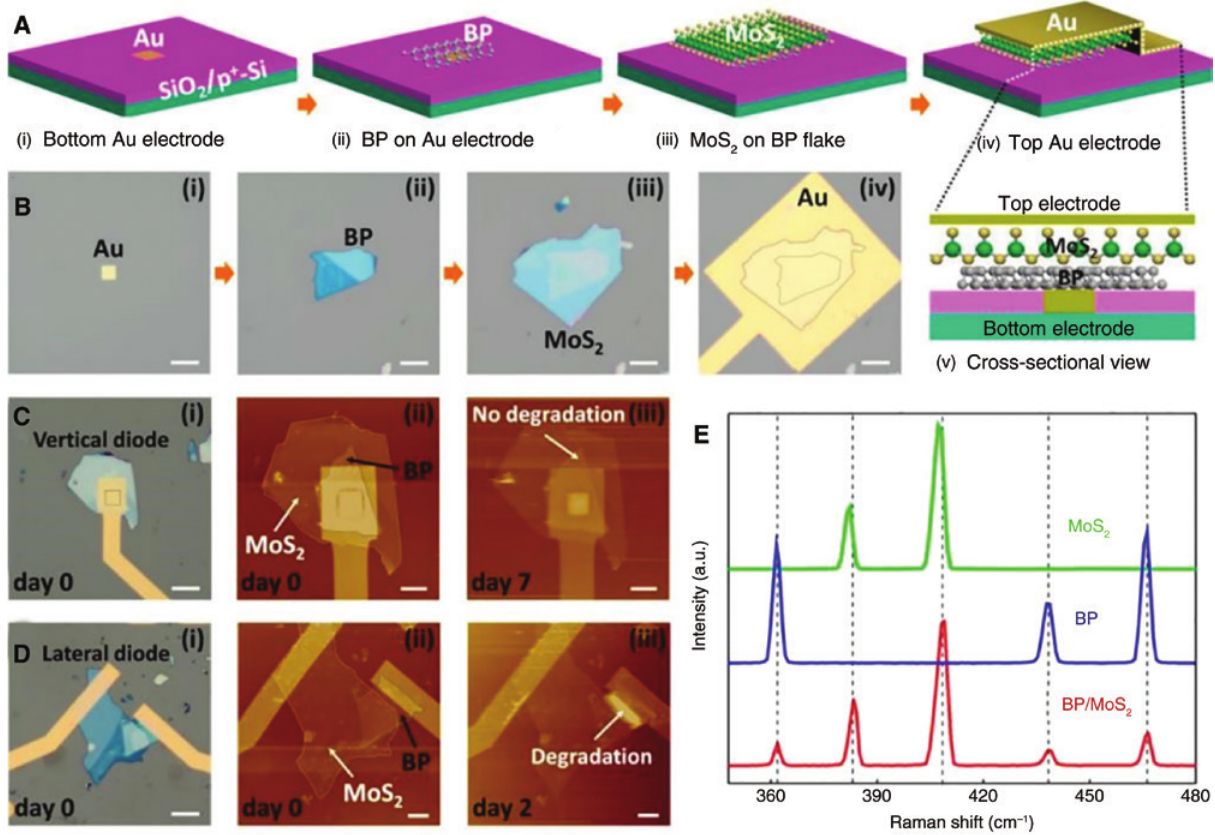
heterojunction p-n diodes. (A) Schematic 2 p-n diodes. A 50 nm-thick Au film was used to fill the 2